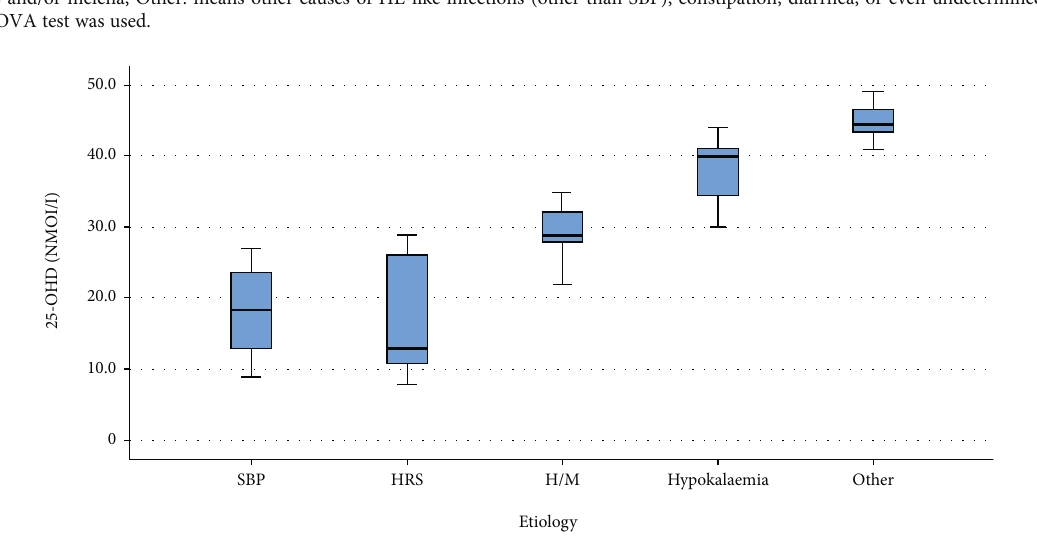
Figure 2: Comparison of 25-OHD levels in di ff erent HE etiologies (A fifi , Hussein, and Rizk, 2020). Table 6: Comparison of 25-OHD level in di ff erent SBP categories.